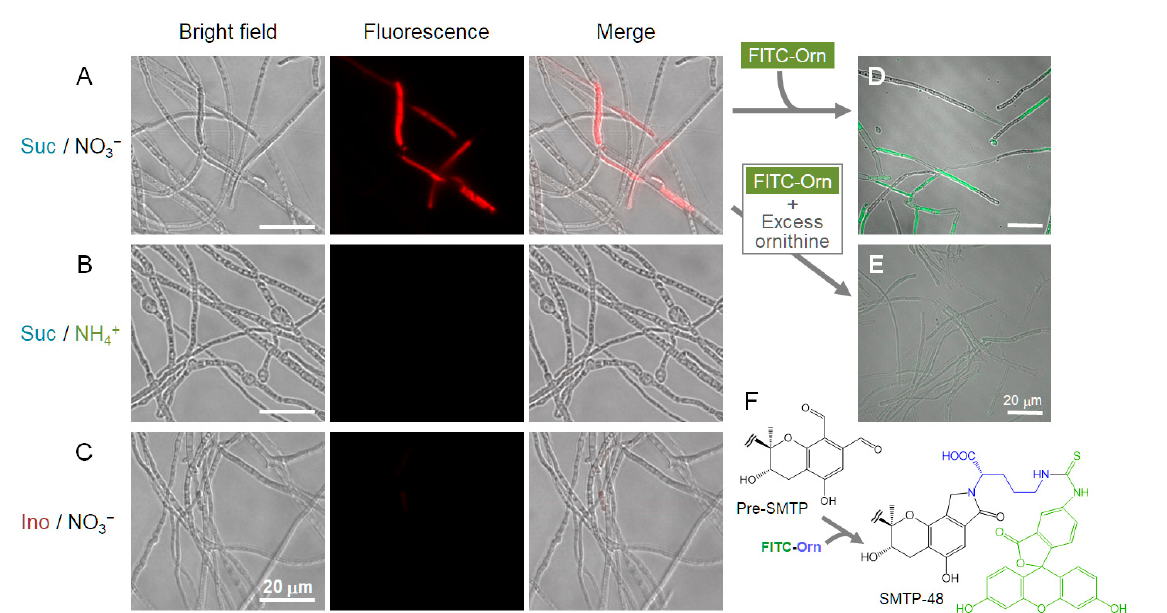
FITC − Orn, decreases the fluorescence labeling of cells ( E